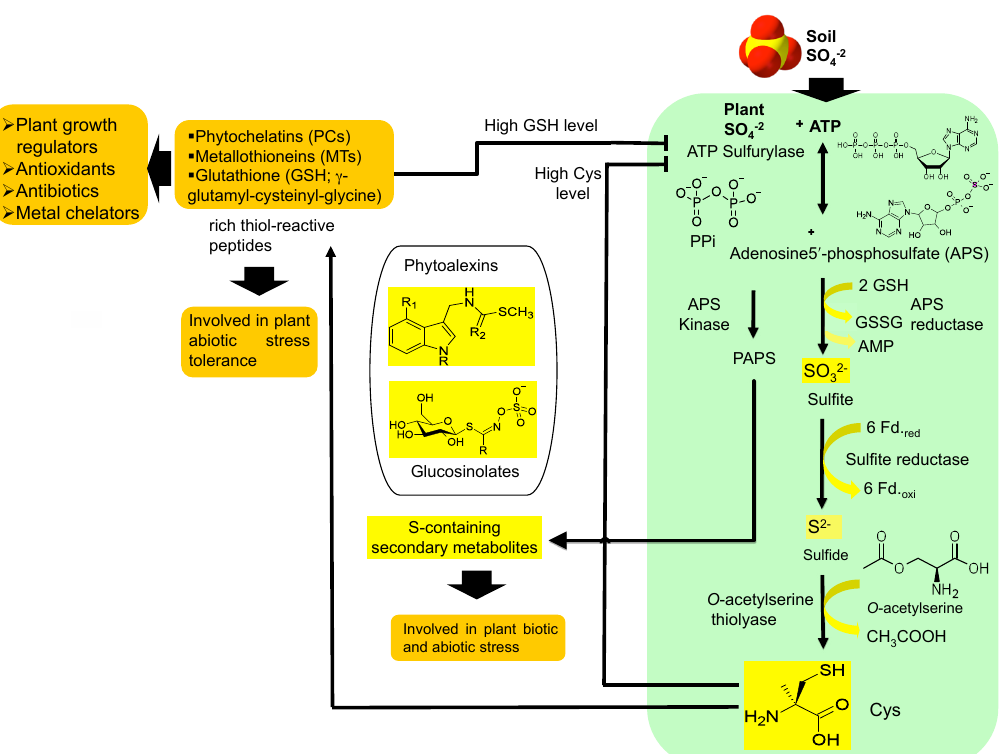
Fig. 1.: Sulfur assimilation pathway. The initial step of sulfur assimilation pathway is catalyzed by ATP-sulfurylase. Role of ATP-sulfurylase in plant abiotic and biotic stress tolerance through different rich thiol-reactive peptides including (Cys, GSH, and MTs) and S-containing secondary metabolites is listed. Positive and negative regulation of ATP-sulfurylase is indicated by arrows and blunt ends, respectively (Redrawn from S Aito 2004; h irAi and S Aito